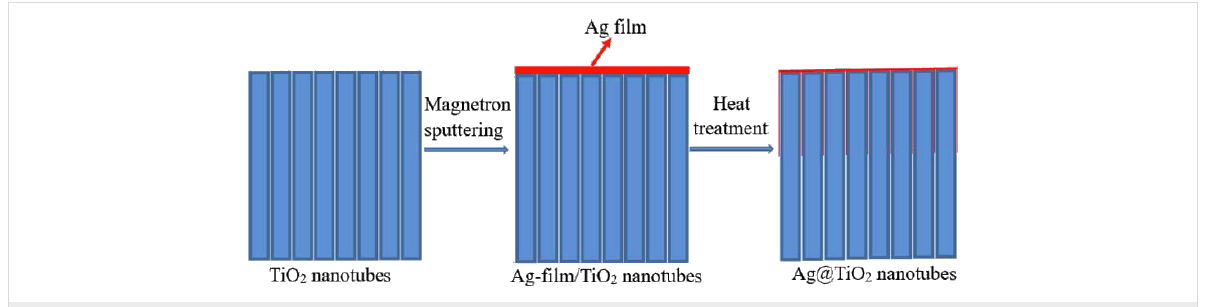
Figure 1: Schematic of the facile route for the preparation of Ag@TiO 2 nanotubes.